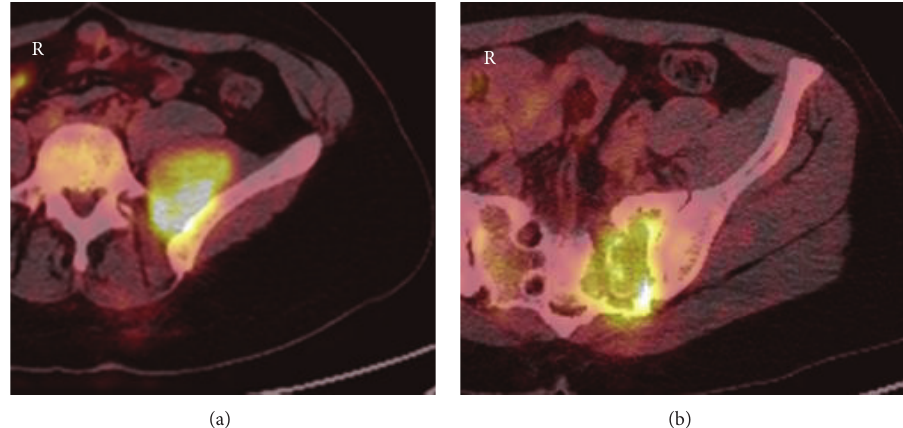
Figure 1: PET CT left osteolytic sacral lesion of 6.2 × 3.5 × 8.6 cm S1, S2, and S3 vertebral involvement extending to the neural foramina with very intense hypermetabolism.